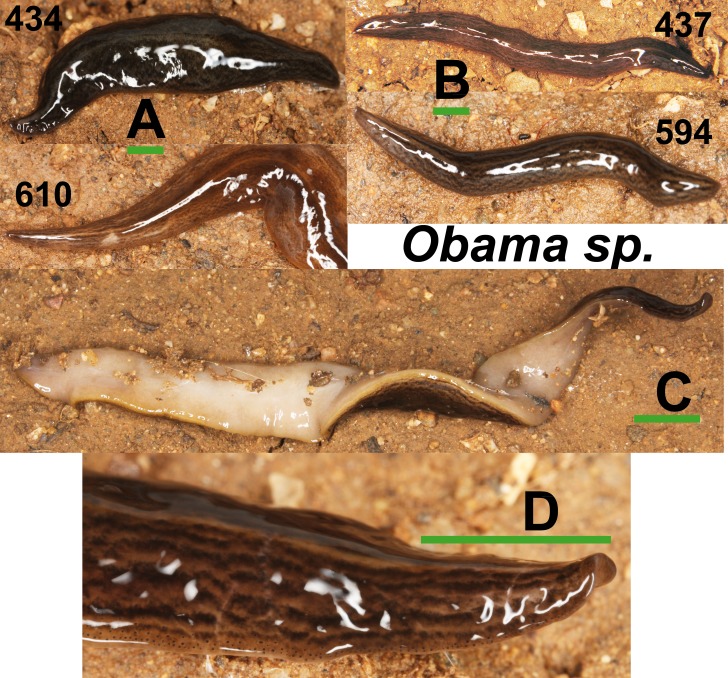
Obama sp.(A) Dorsal view of two specimens (codes 434 and 610) from one Obama sp. A clade in the Geoplaninae Cox1 tree (Fig. 14). (B) Dorsal view of two specimens (codes 437 and 594) from Obama sp. B clade in the Geoplaninae Cox1 tree (Fig. 14). (C) Ventral view. (D) Lateral view of anterior end showing line of eyes. Scale bar 5 mm.